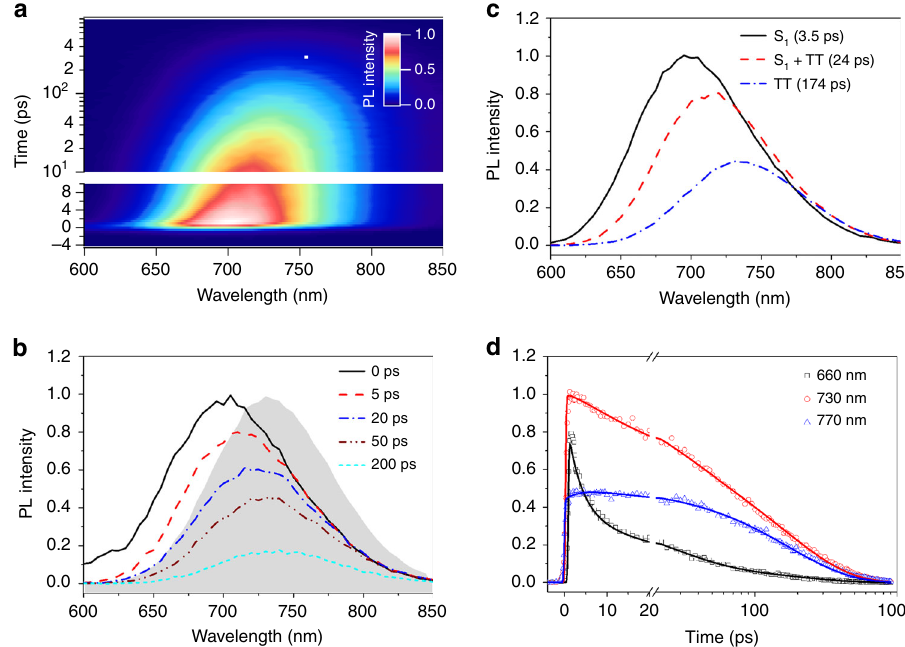
Fig. 3 Transient fl uorescence data. a Broadband transient photoluminescence of IIDDT-Me in dilute DCB solution. b The transient spectra extract at different time delays (solid lines) and the integrated PL spectra ( fi lled gray curve). c Results of a three species sequential global analysis model showing the characteristic emission spectrum of singlet exciton (S 1 ), triplet pair (TT), and coexistence state (S 1 + TT). d Kinetic traces taken from the raw data set at 660, 730, and 770 nm (open circles) along with fi ts derived from global fi tting (solid lines)